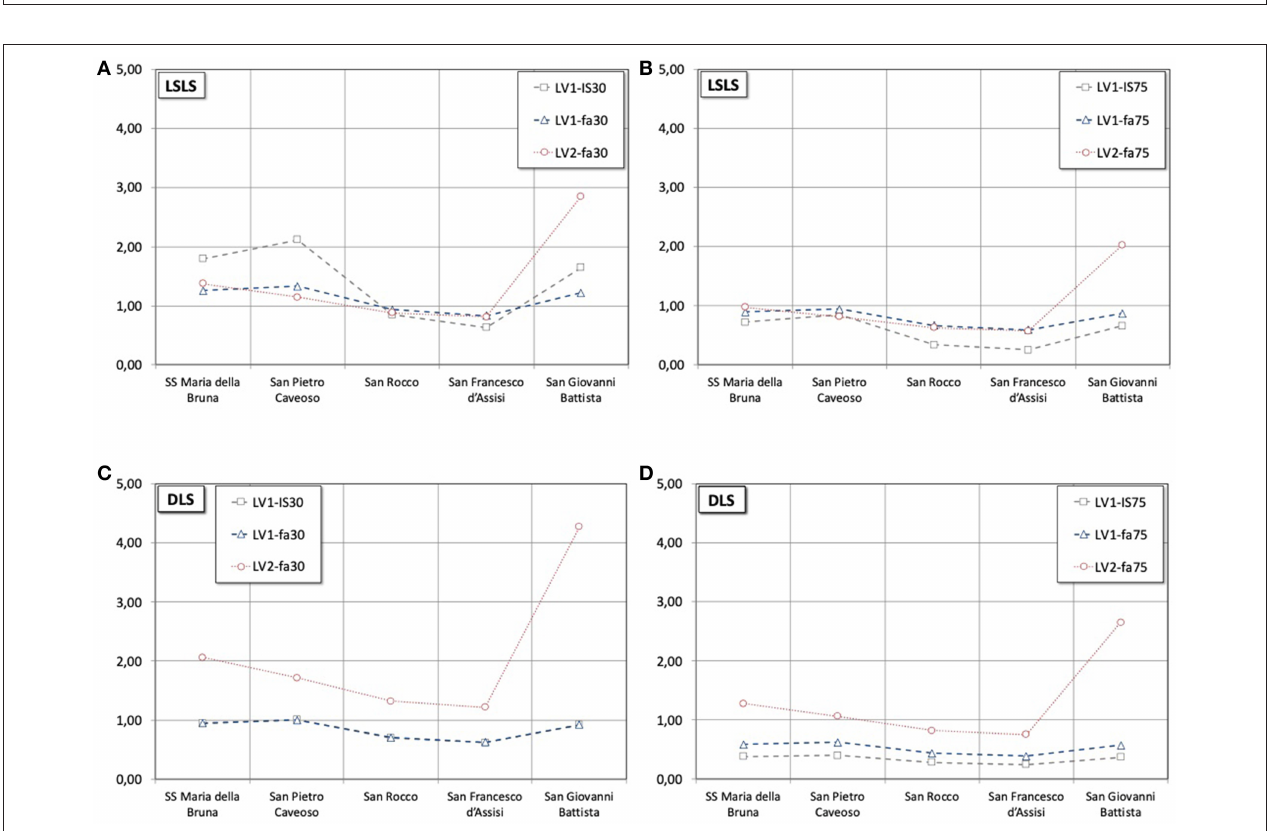
FIGURE 7 | LV1 and LV2 methods. LSLS: (A) V R = 30 years and (B) V R = 75 years. DLS: (C) V R = 30 years and (D) V R = 75 years.